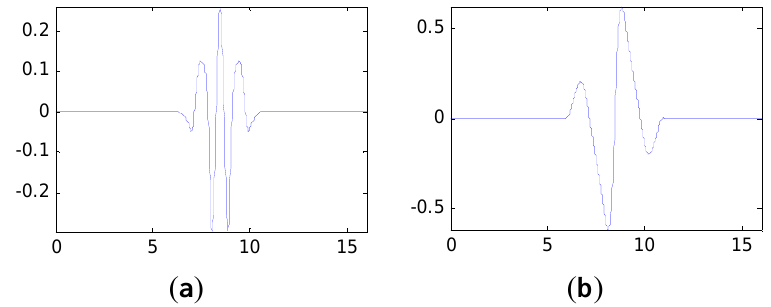
 and  constructed for vibration signal under assembly 1 2  ; ( b ) 1